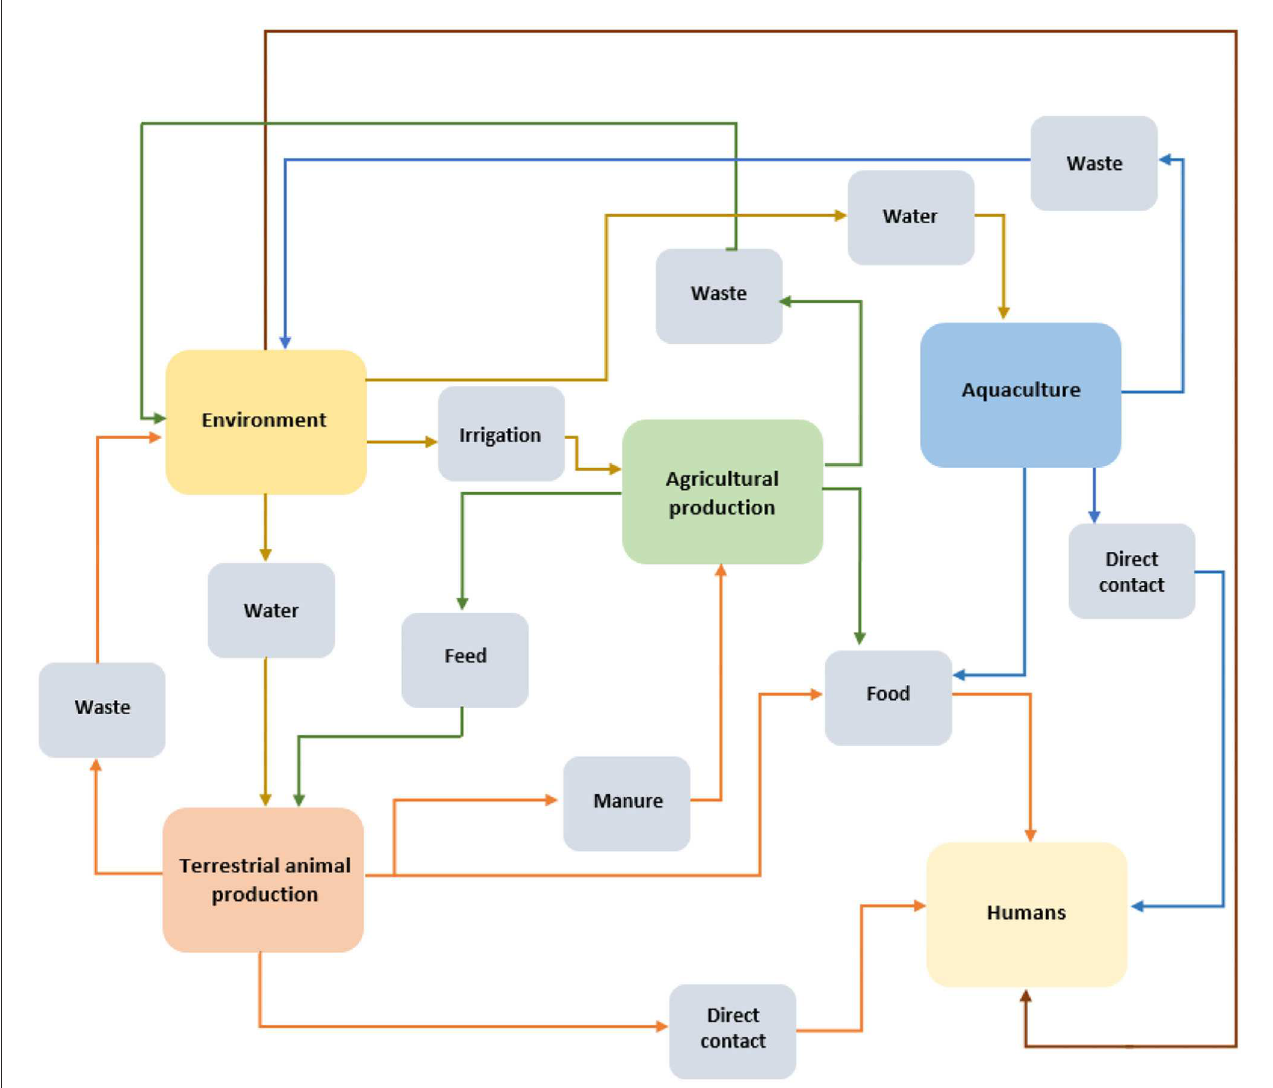
FIGURE1 A simplified representation of AMR epidemiology routes from antimicrobial use in animal